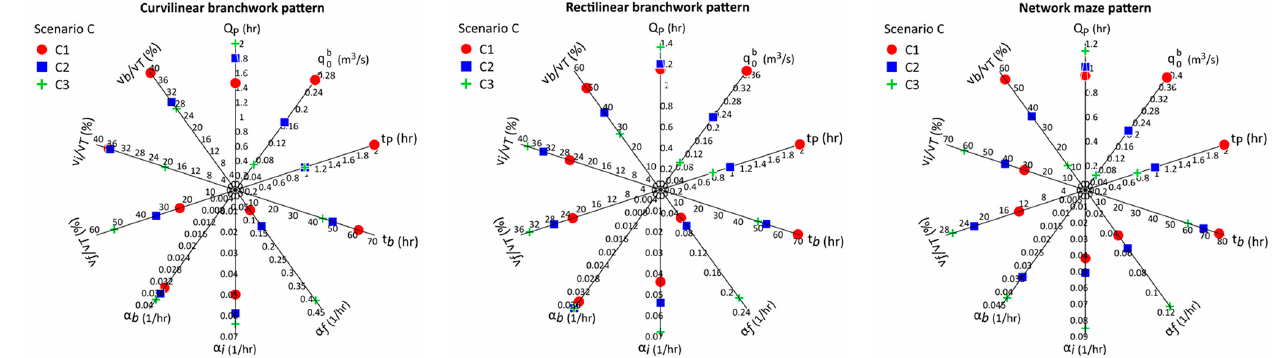
Figure 17. Comparison of different spring hydrograph characteristics in scenario C.